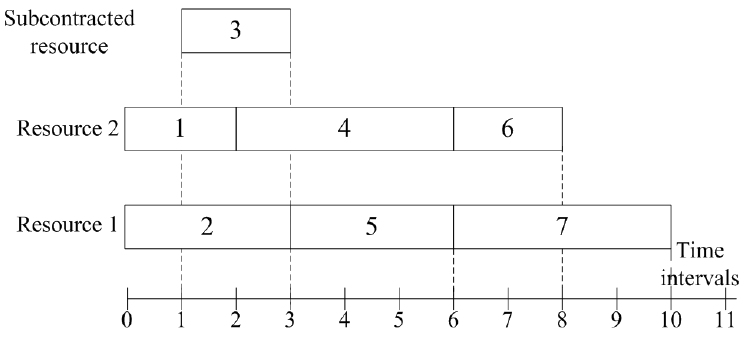
Figure 4. Schedule with the most effective resource allocation.